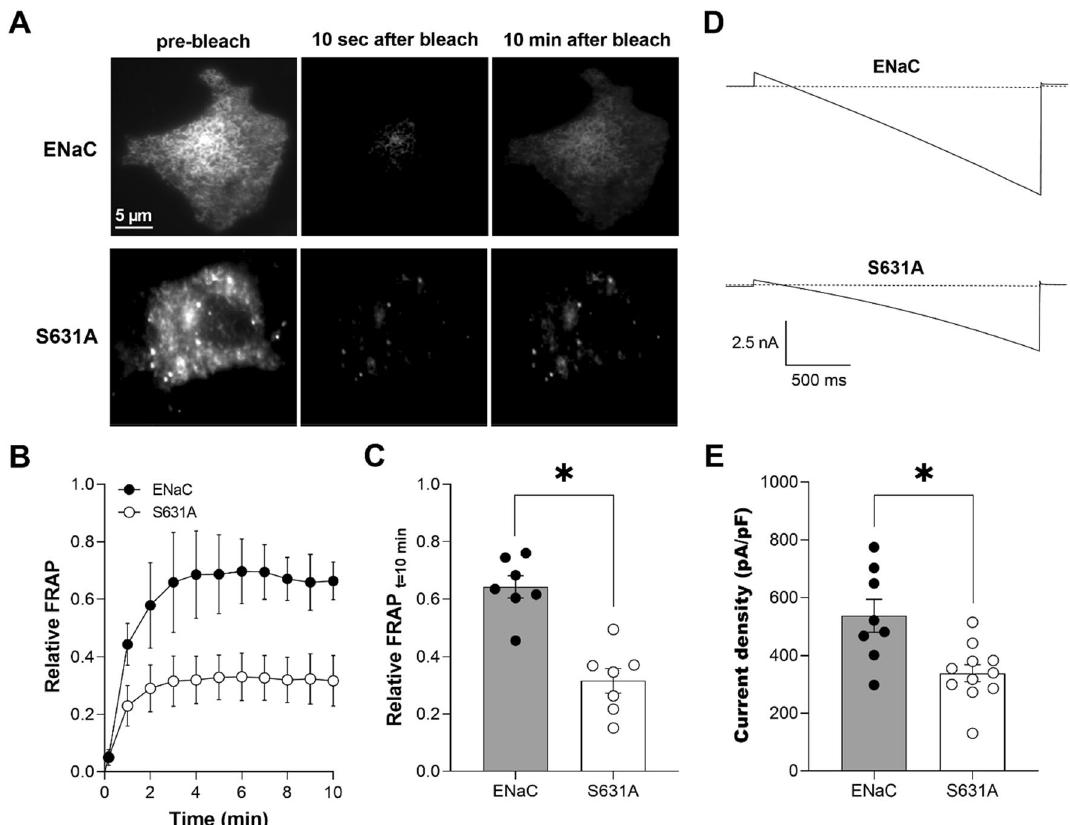
Figure 3. Disrupting the CKII phosphorylation site in ENaC decreases trafficking toward the plasma membrane and channel activity. ( A ) Fluorescence micrographs of COS-7 cells expressing eYFP-ENaC (top) and eYFP-αβ S631A γ-ENaC (bottom) prior to photobleaching (left) and 10 s (middle) and 10 min (right) after photobleaching. Images were collected with TIRF microscopy. ( B ) Time course of relative FRAP at the plasma membrane for cells expressing eYFP-ENaC (black circles) and eYFP-αβ S631A γ-ENaC (white circles). Summary data from experiments (n = 7 cells from 2–3 distinct transfections) identical to those shown in ( A ). ( C ) Summary graph of relative FRAP 10 min after photobleaching in cells expressing eYFP-ENaC (black circles, gray bar) and eYFP-αβ S631A γ-ENaC (white circles, white bar). Summary data from experiments identical to those shown in ( A ). *P < 0.05 vs wild-type ENaC. ( D ) Overlays of typical macroscopic current traces from representative CHO cells expressing mENaC (top) and αβ S631A γ-ENaC (bottom) before and after 10 µM amiloride (dotted lines). Currents elicited by stepping voltage from a holding potential of 40 mV to 60 mV and ramping to − 100 mV. ( E ) Summary graph of ENaC activity (amiloride-sensitive current density at -100 mV) quantified in whole-cell voltage clamped CHO cells transfected with mENaC (black circles, gray bar) and αβ S631A γ-ENaC (white circles, white bar). Summary data from experiments (n = 8–11 cells from 3–5 distinct transfections) identical to those shown in ( D ). *P < 0.05 vs. wild-type